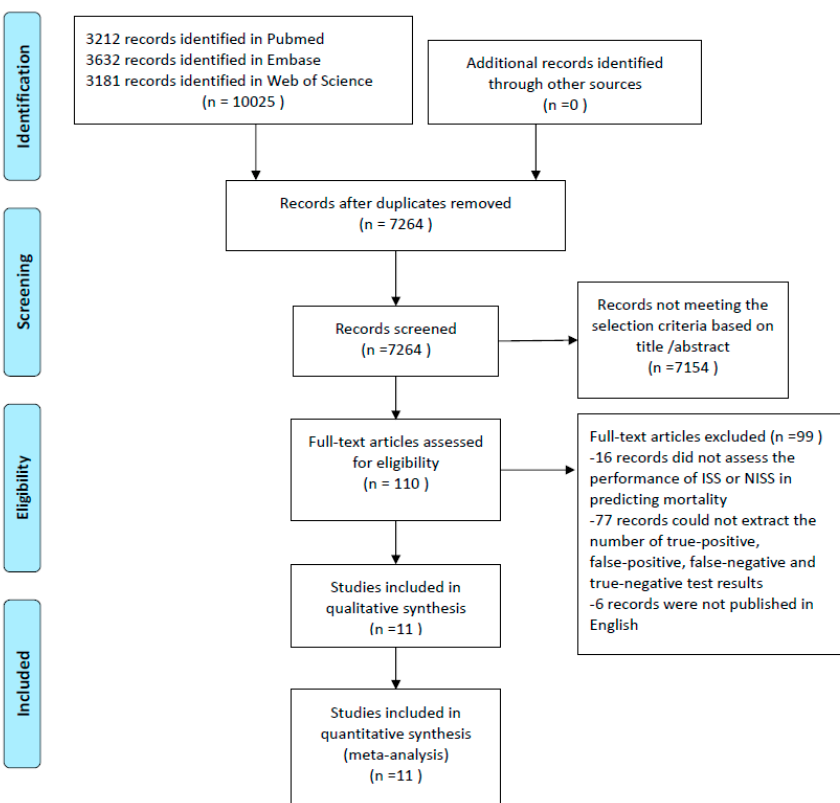
Figure 1. Flow chart showing study selection for the meta-analysis regarding the ability of the Injury Severity Score and New Injury Severity Score to predict mortality.